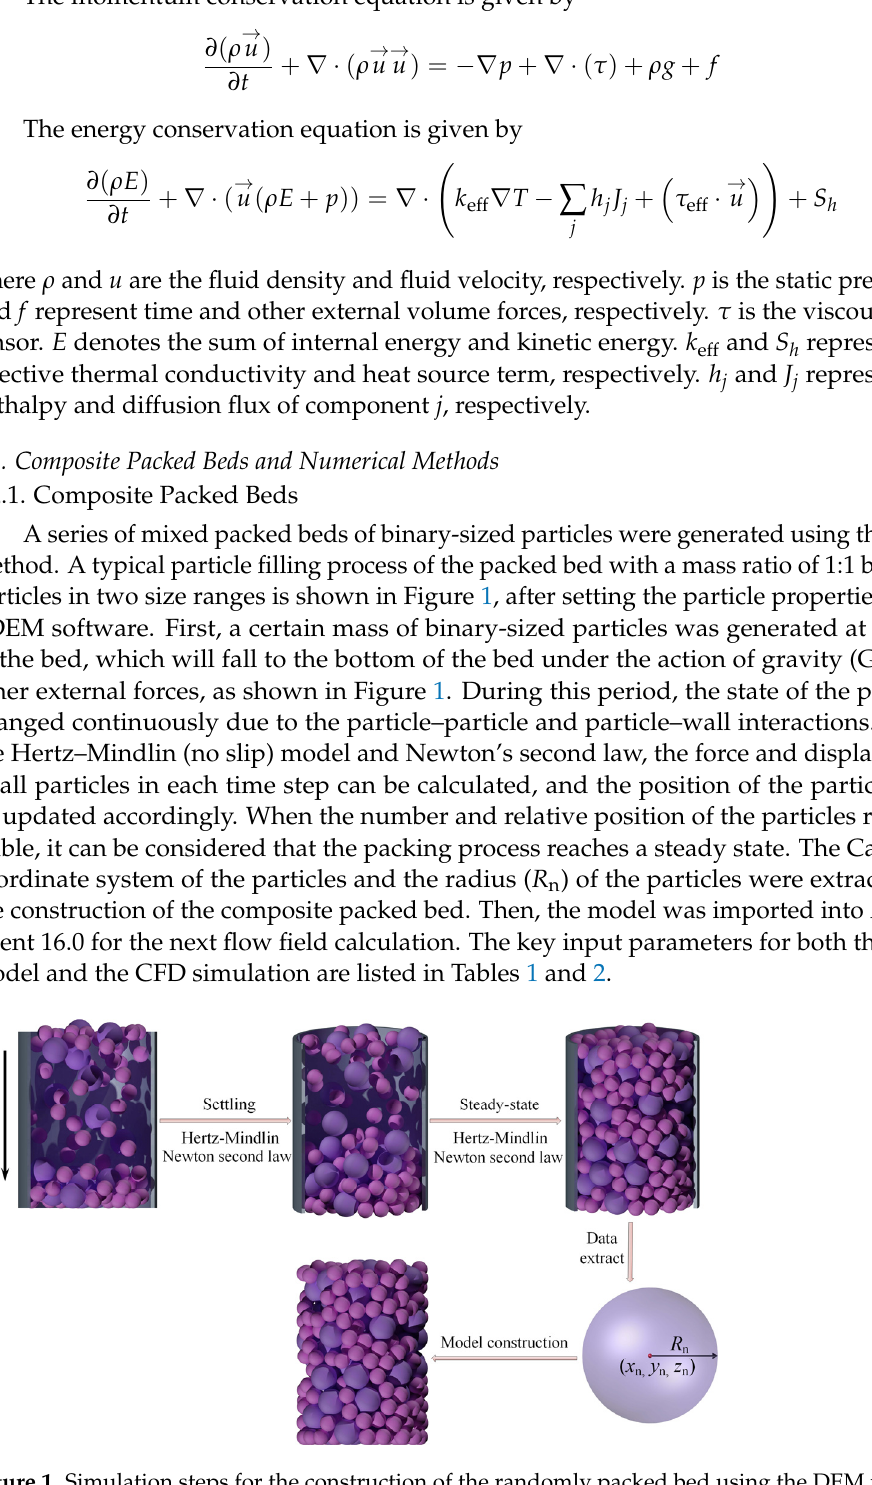
Figure 2. Binary mixed packing beds: ( a ) b100; ( b ) b75s25; ( c ) b50s50; ( d ) b25s75; ( e ) s100.